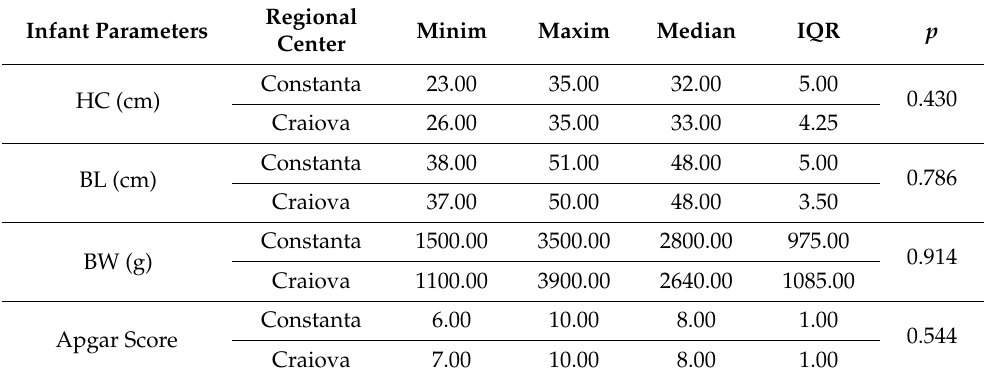
Table 1. Anthropometric parameters and Apgar score of HIV-positive newborns.